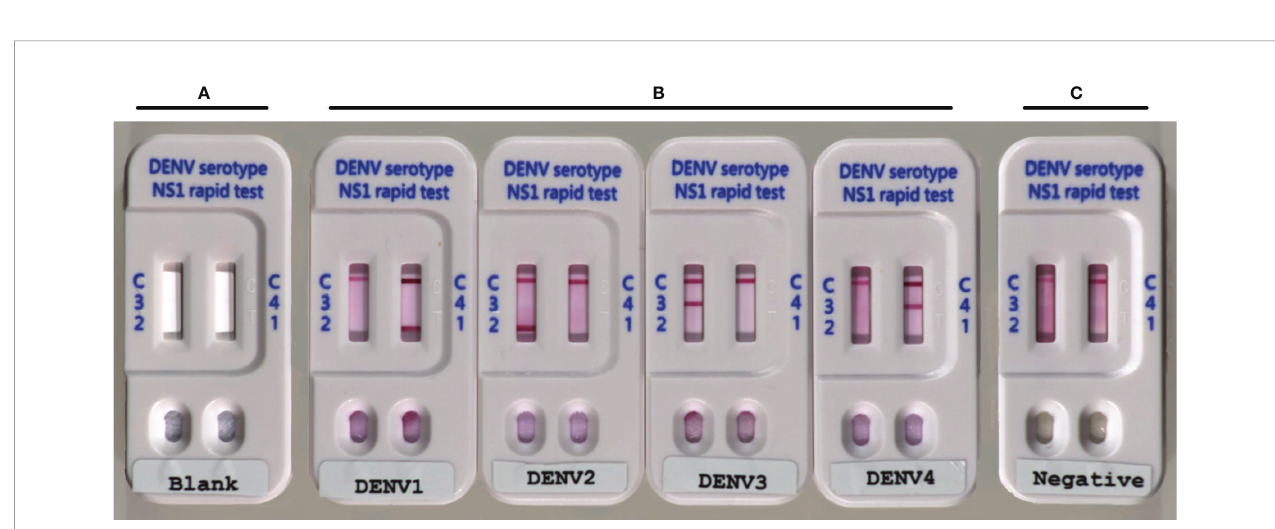
FIGURE 2 | Photographs showing Dengue serotype NS1 multiplex LFIA: (A) Blank; (B) positive for DENV1-4 NS1 proteins, with colored band corresponding to the band at the test line; and (C) negative for DENV1-4, with bands at the test line (T) absent.